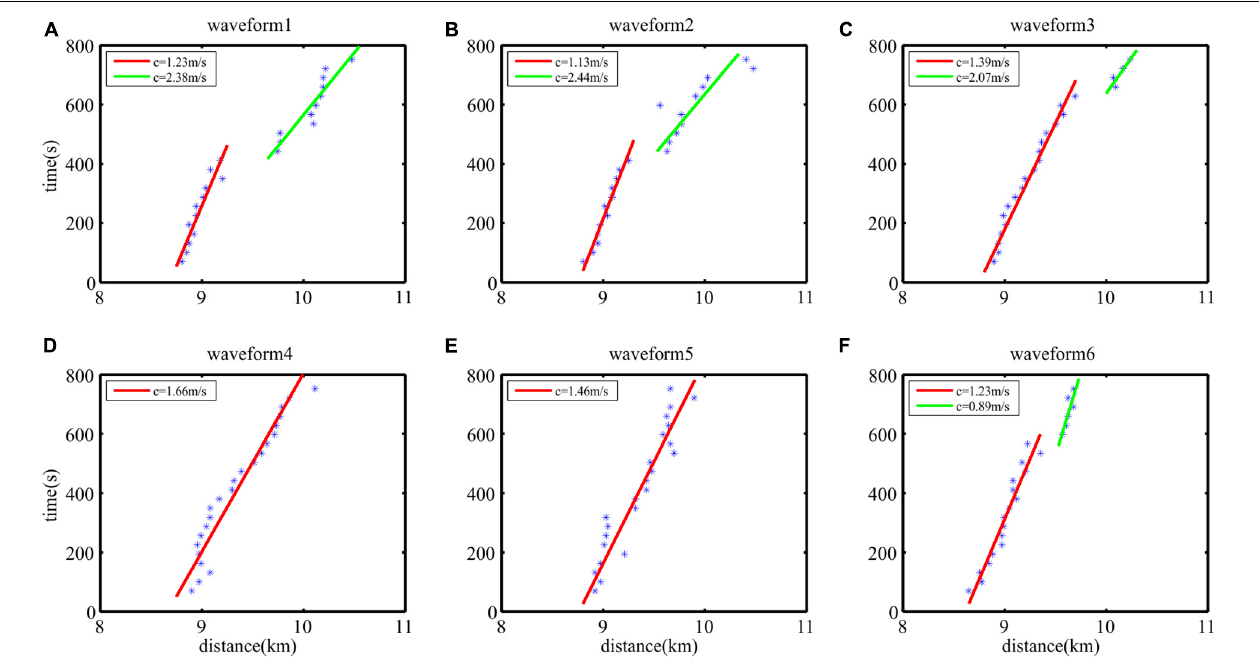
FIGURE 7 | Linear fitting in phase velocity calculation process of the six waveforms. (A–F) The blue asterisks indicate the trough of waveform. The red and green lines are fitting lines of blue asterisks. The common midpoint (CMP)-shot coordinates have been converted into the distance-time coordinates, so that the slope of fitting line is the phase velocity. The red and green lines are different fitting of asterisks, which indicate that the internal solitary waves travel in different phase velocity.